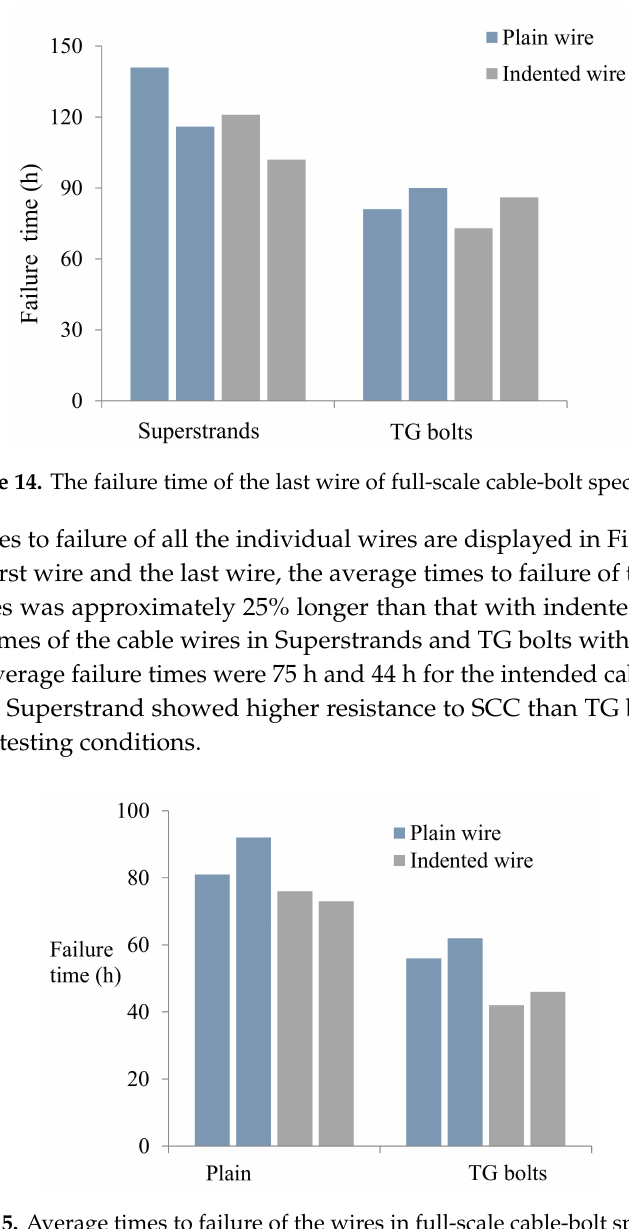
Figure 13. Time to failure of the first wire of full-scale cable-bolt specimens.